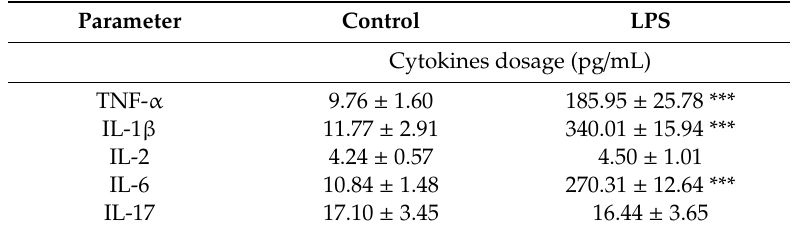
Table 2. Cytokines release by LPS-stimulated human PBMC. *** p < 0.001 vs. ctrl.